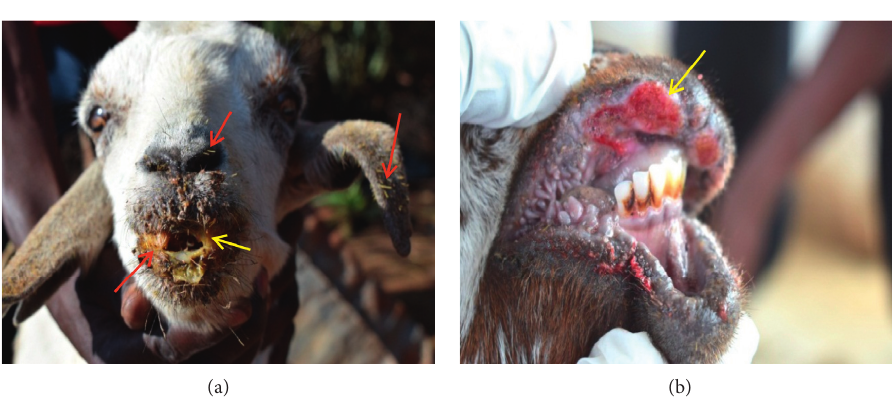
Figure 4: Septic ulcerative wounds (yellow arrows) on the lips, gum, and oral mucosa (a and b); nasal and oral mucopurulent discharges in a goat unable to close its oral cavity due to severe wounds and many spines of Opuntia stricta on the oral mucosa (pear mouth-like condition) and spines in the ear lobes and nostrils (a) (red arrows).